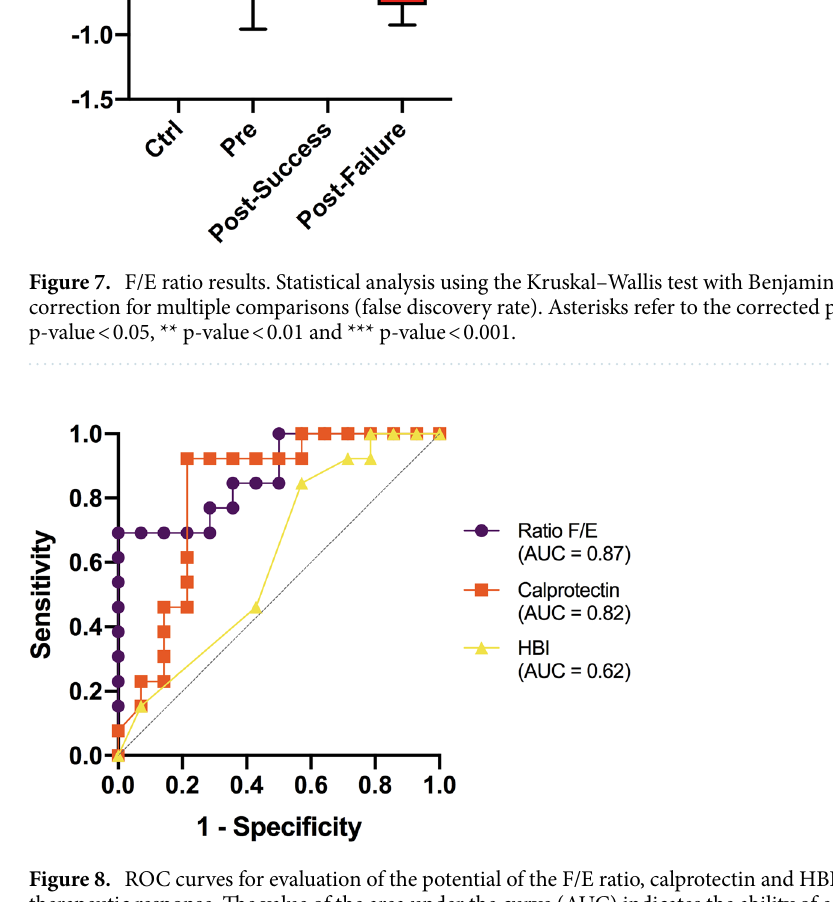
Figure 8. ROC curves for evaluation of the potential of the F/E ratio, calprotectin and HBI as biomarkers of therapeutic response. The value of the area under the curve (AUC) indicates the ability of each set of parameters studied as biomarkers of response in anti-TNF